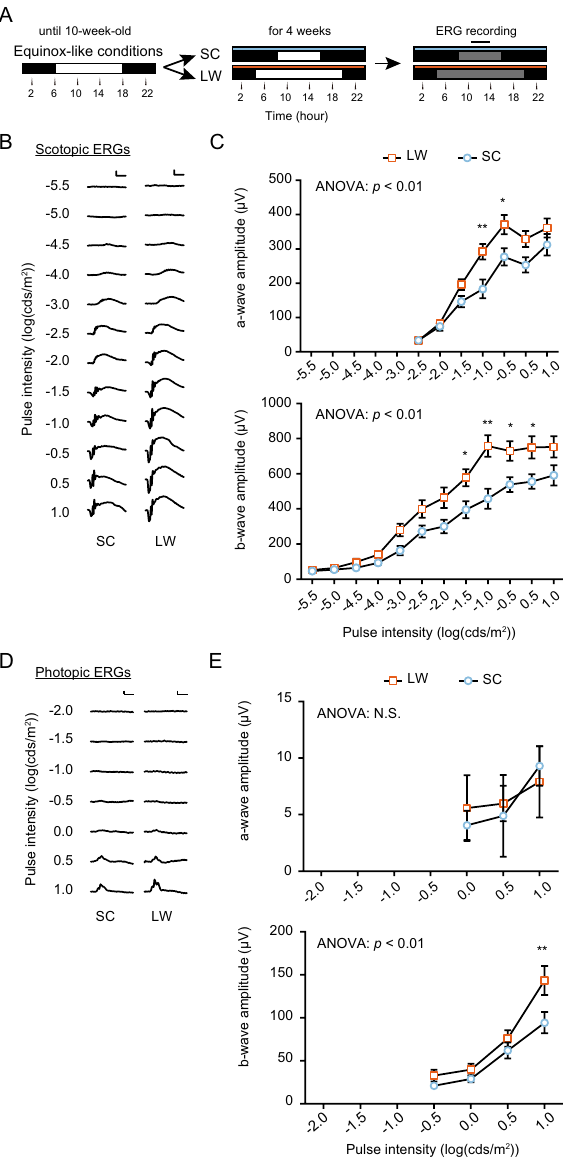
Figure 1. Seasonal changes in the mesopic ERG response in mice. ( A ) Flow of the experiment for ERG recording. Black and white bars indicate dark and light periods, respectively. Blue and orange bars indicate cool (10 °C) and warm (27 °C) conditions, respectively. SC: short day and cool temperature (winter-like condition); LW: long day and warm temperature (summer-like condition). ERG recording was conducted at around midday (black solid line) under darkness (gray bar) (i.e., dark adaptation). ( B ) Scotopic pulse ERGs elicited using 12 different intensities (from − 5.5 to 1.0 (log cds/m 2 )) in SC and LW mice (scale bar: 200 µV [vertical], 50 ms [horizontal]). ( C ) Intensity–response curves of mean scotopic a- and b-wave amplitudes. (Two-way ANOVA, effect of seasonal cues, F (1, 154) = 23.73, p < 0.01 [a-wave]; F (1, 264) = 57.19, p < 0.01 [b-wave], Bonferroni post hoc test: * p < 0.05, ** p < 0.01; effect of pulse intensity, F (6, 154) = 64.55, p < 0.01 [a-wave], F (11, 264) = 72.29, p < 0.01 [b-wave]; effect of interaction, F (6, 154) = 1.901, p = 0.0840 [a-wave], F (11, 264) = 2.326, p < 0.01 [b-wave], means ± SEM, n = 12 [animal]). ( D ) Photopic pulse ERGs elicited using different intensities (from − 2.0 to 1.0 log (cds/m 2 )) in SC and LW mice (scale bar: 50 µV [vertical], 50 ms [horizontal]). ( E ) Intensity–response curves of mean photopic a- and b-wave amplitudes (two-way ANOVA, effect of seasonal cues, F (1, 66) = 0.03748, p = 0.8471 [a-wave];